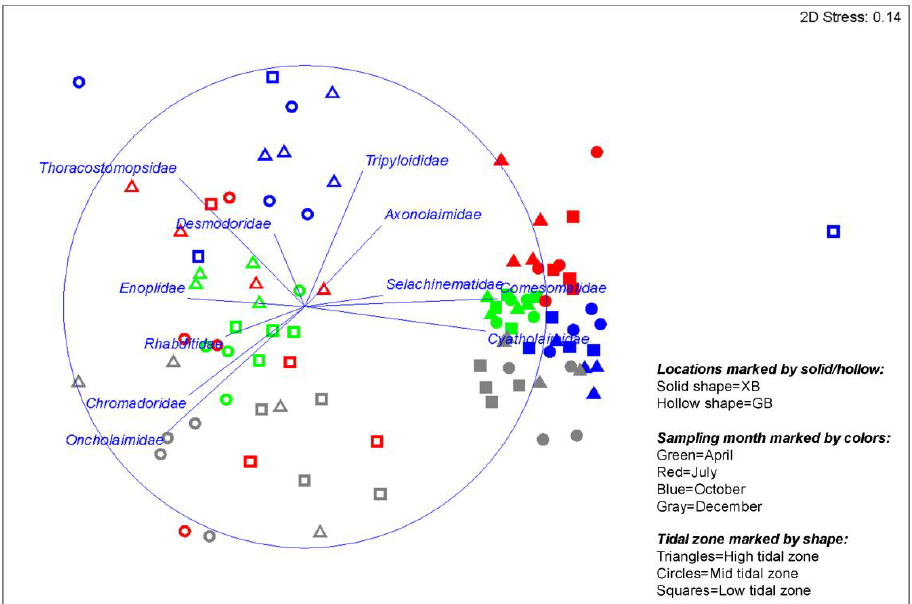
Figure 4. Non-metric multidimensional scaling (nMDS) of nematode community. Nematode spe- cies data were standardized and fourth root transformed. Vectors overlain on plot show correla- tions of families (>0.3) with nMDS axes, indicating important families that differentiate the com- munities.